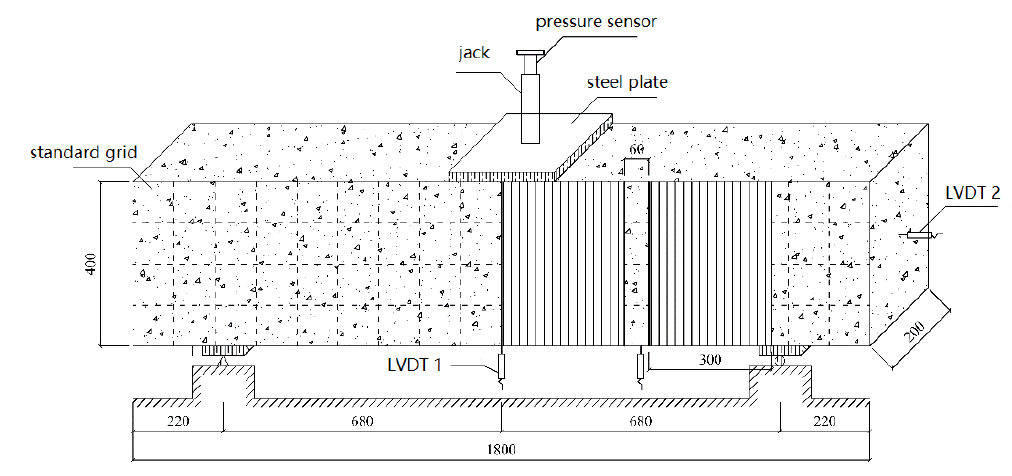
Figure 3. FRP strengthened RC beams program (unit: mm).